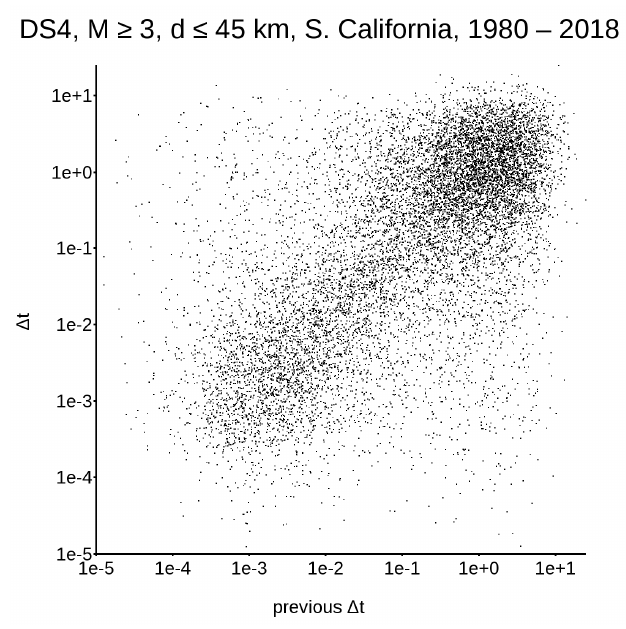
Figure 2. Distribution between earthquake triplets in DS1; abscissa: ∆ t [ i , i − 1 ] , ordinate: ∆ t [ i + 1, i ] .